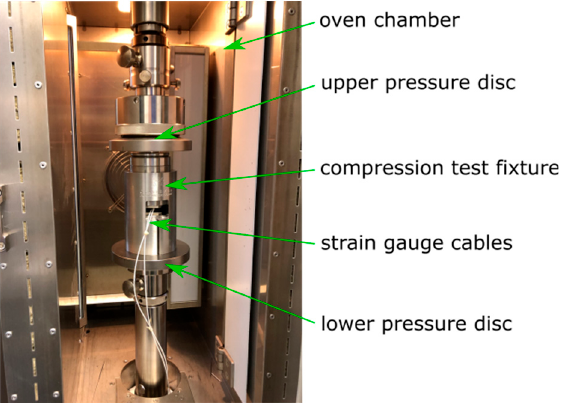
Figure 7. Compression creep test fixture in an oven chamber of a universal testing machine.